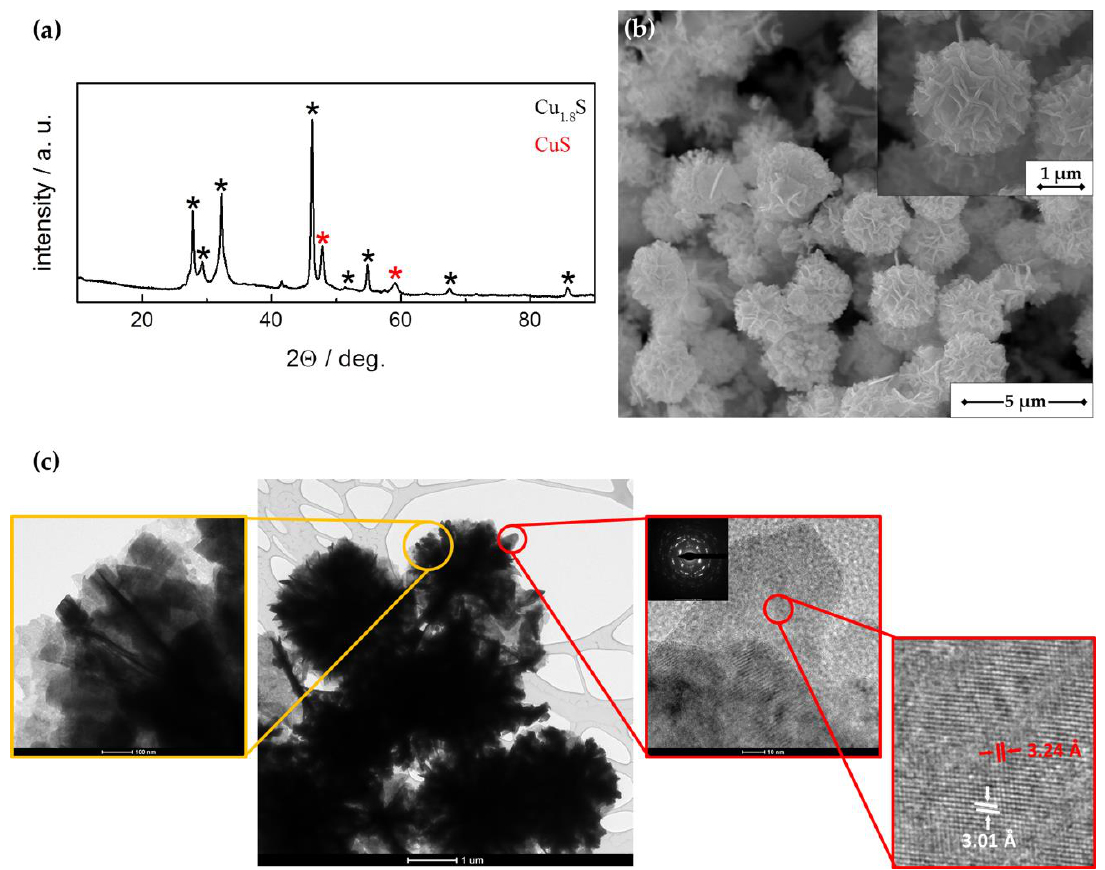
Figure 1. Characterization of copper sulfides: ( a ) X-ray diffraction pattern; ( b ) SEM images with different magnifications; ( c ) TEM and HR-TEM images showing d-spacing 3.24 Å and 3.01 Å corresponding to (101) plane of CuS and (018) plane of Cu 1.8 S, respectively.